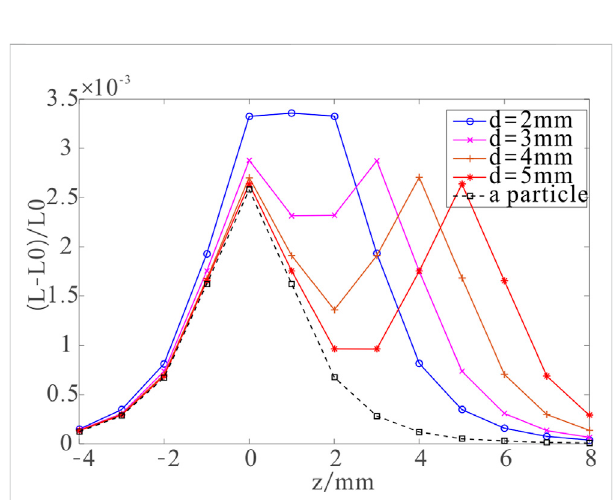
FIGURE 5 Coil outputsignals whentwoparticleslocated onthecentral axis with a distance of d pass through the coil.